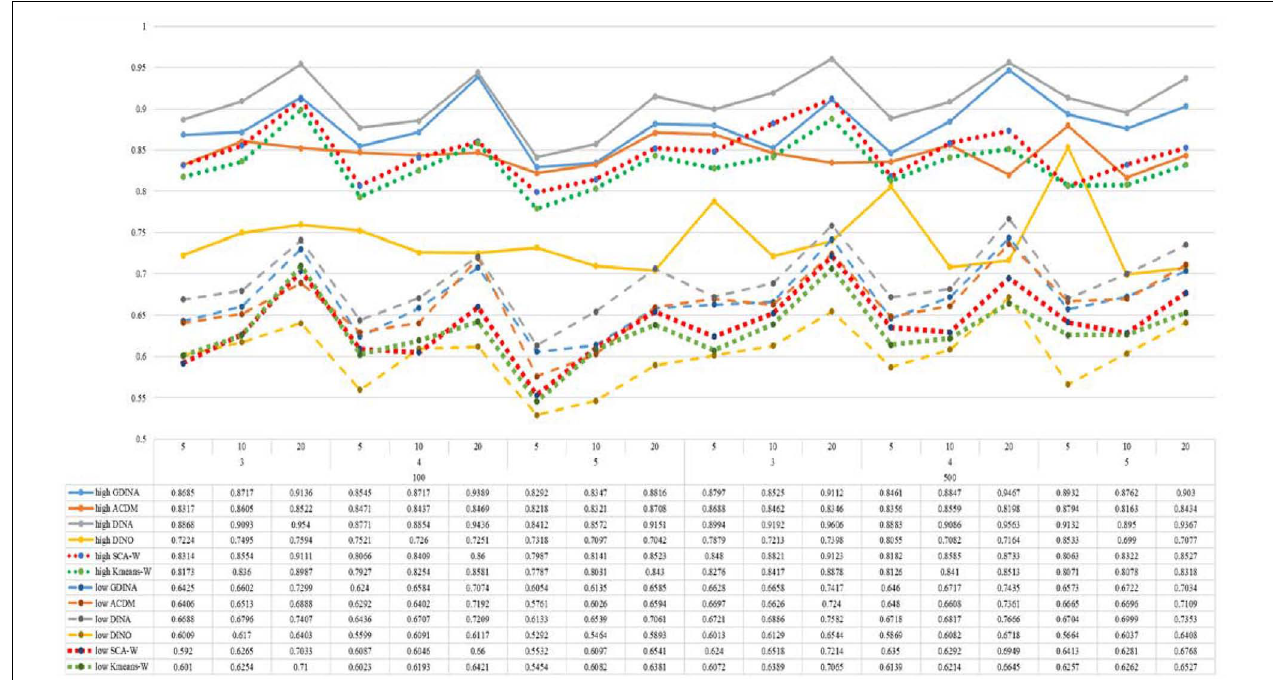
FIGURE 6 | Mean values of ω by SCA, K-means, and fitted models; True model = DINA.